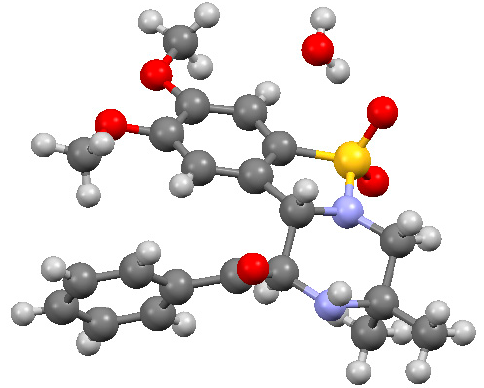
Figure 2. X-Ray crystal structure of compound 11 (dark grey = carbon; light grey = hydrogen; red = oxygen; blue = nitrogen; yellow = sulfur).